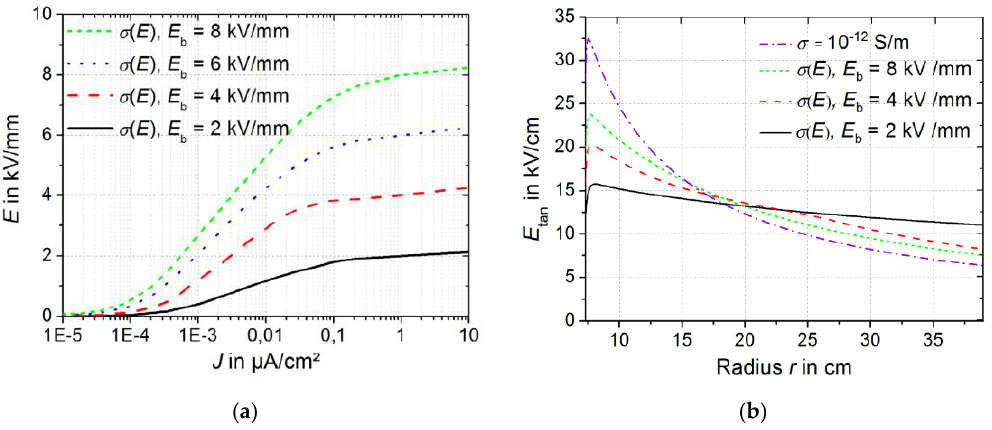
Figure 7. Graphs of the electric conductivity of ZnO microvaristor filled epoxy and the resulting electric field distribution along the insulator’s surface. ( a ) Nonlinear E-J curves. ( b ) Distribution of the tangential electric field E tang along the insulator surface under 500 kV DC in comparison with that of σ = 10 −12 S/m [42].